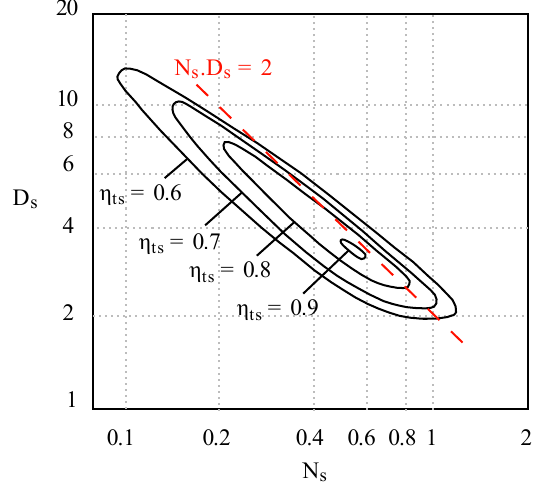
Figure 1. N s - D s map correlations. These data are extracted from Balje [6] and redrawn by the